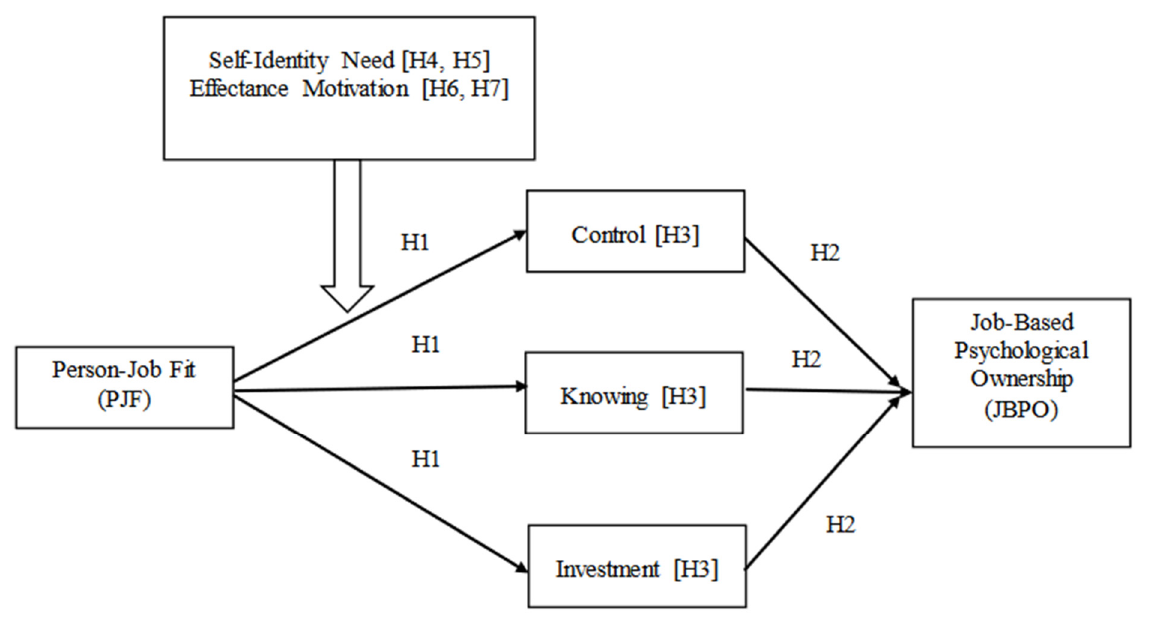
Figure 1. Illustration of hypothesized relationships between person-job fit, motivational needs, routes to and job-based psychological ownership.